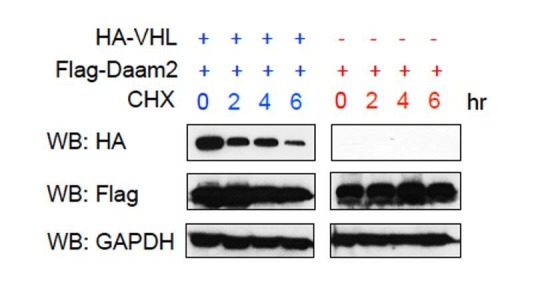
High levels of VHL do not reciprocally degrade Daam2.